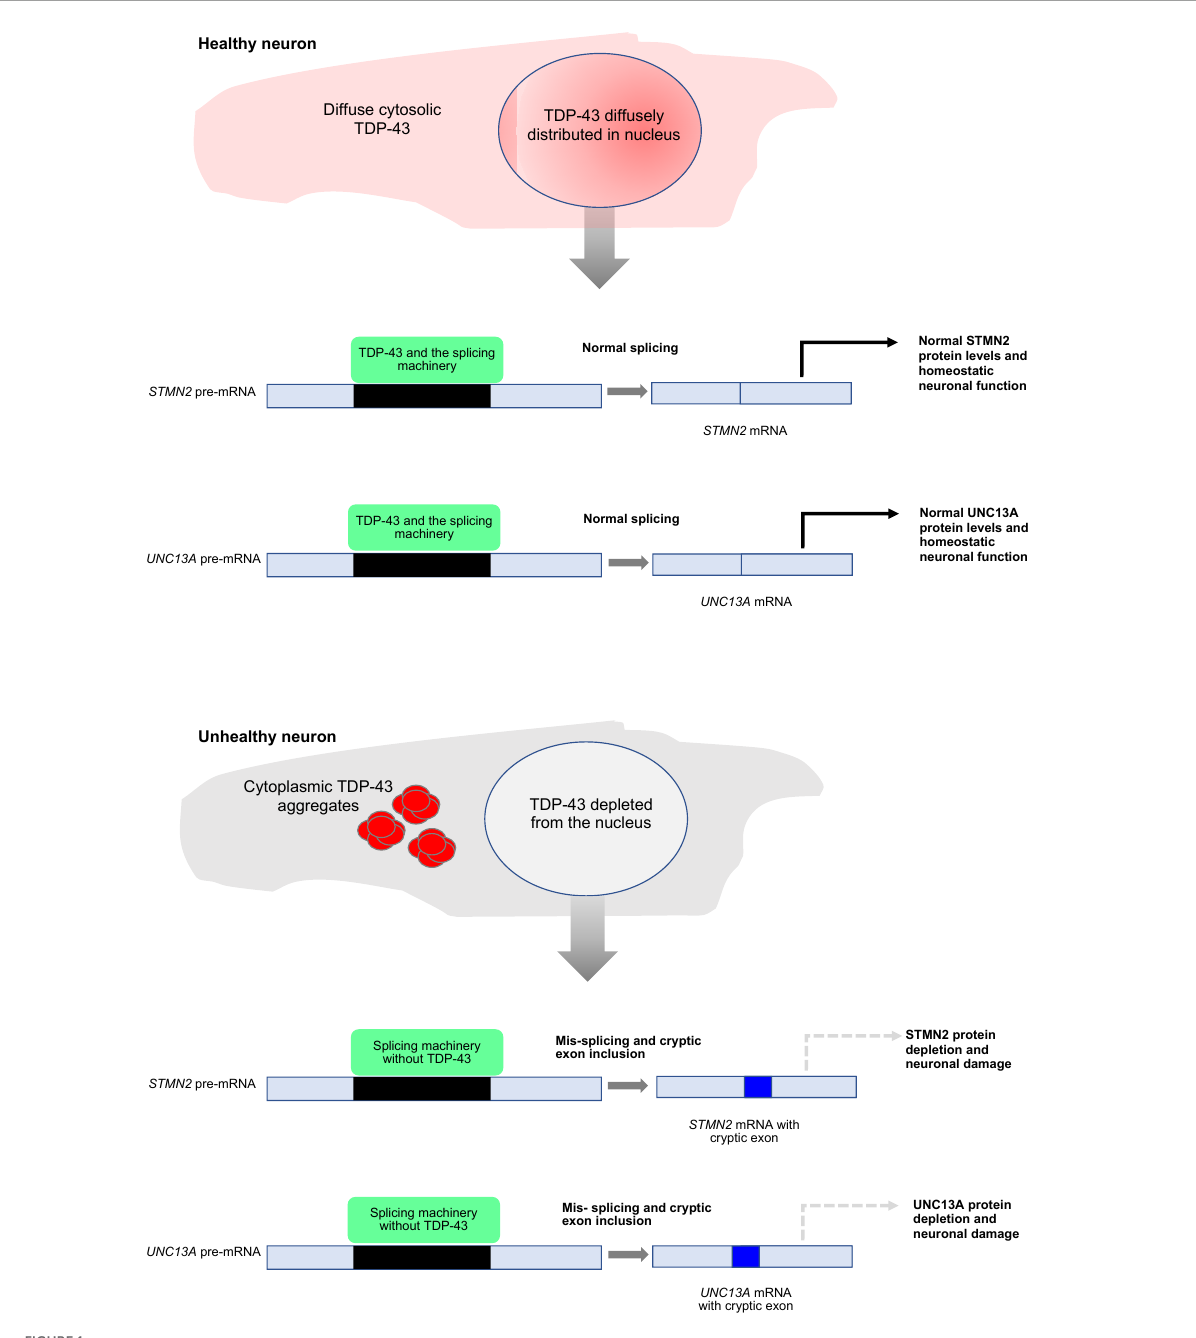
FIGURE1 Schematic depiction of transactivation response element (TAR) DNA-binding protein 43 (TDP-43) mis-localization and neurodegeneration. In healthy neurons, TDP-43 is localized predominantly to the nucleus but is also maintained in the cytoplasm at comparatively low levels via nucleocytoplasmic shuttling. Nuclear TDP-43 facilitates appropriate splicing of target transcripts, leading to normal levels of protein expression ( solid arrows ; for simplicity only STMN2 and UNC13A are shown). Upon aggregation of TDP-43 in the cytoplasm, TDP-43 functions in the nucleus are lost, resulting in the incorporation of cryptic exons during target transcript splicing. The resulting decrease in target protein expression ( dashed arrows ) in turn drives neuronal malfunction and degeneration associated with disease.